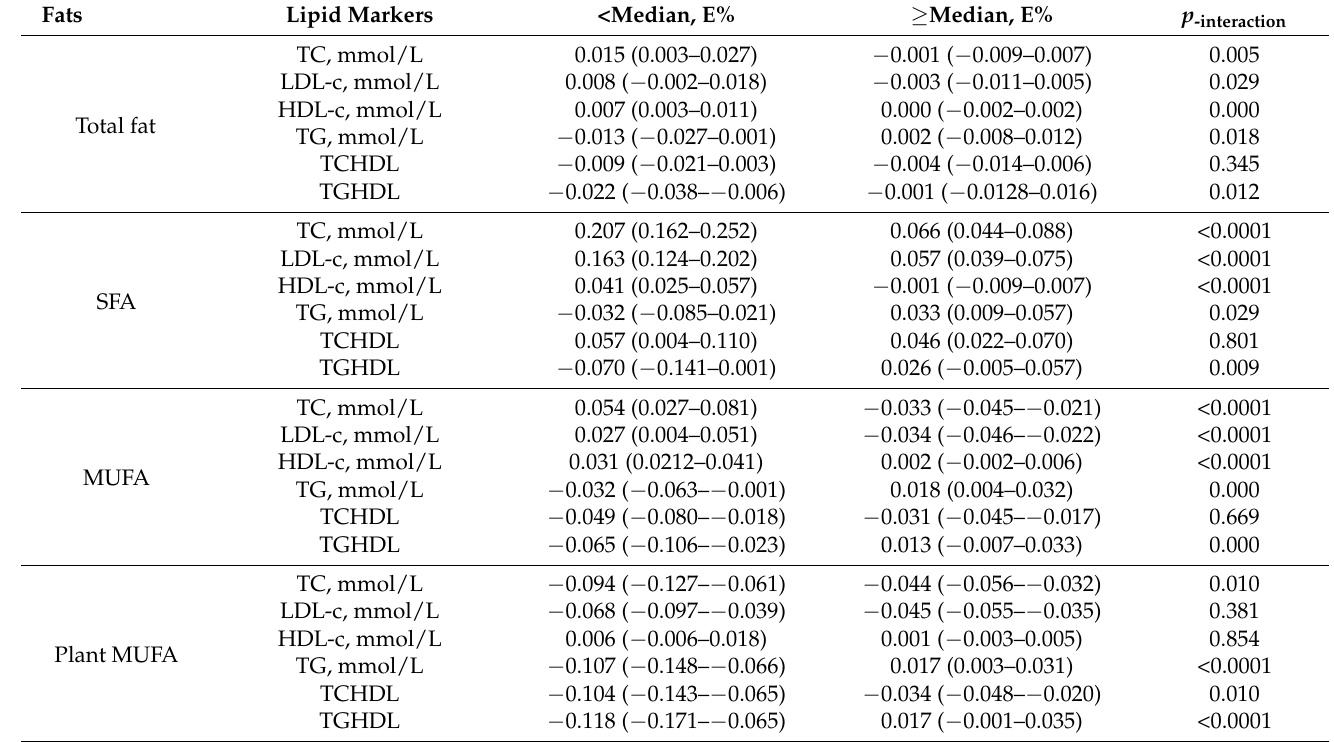
Table 3. Beta coefficient (95% CI) for change in lipid biomarkers for per 11 g increment of total